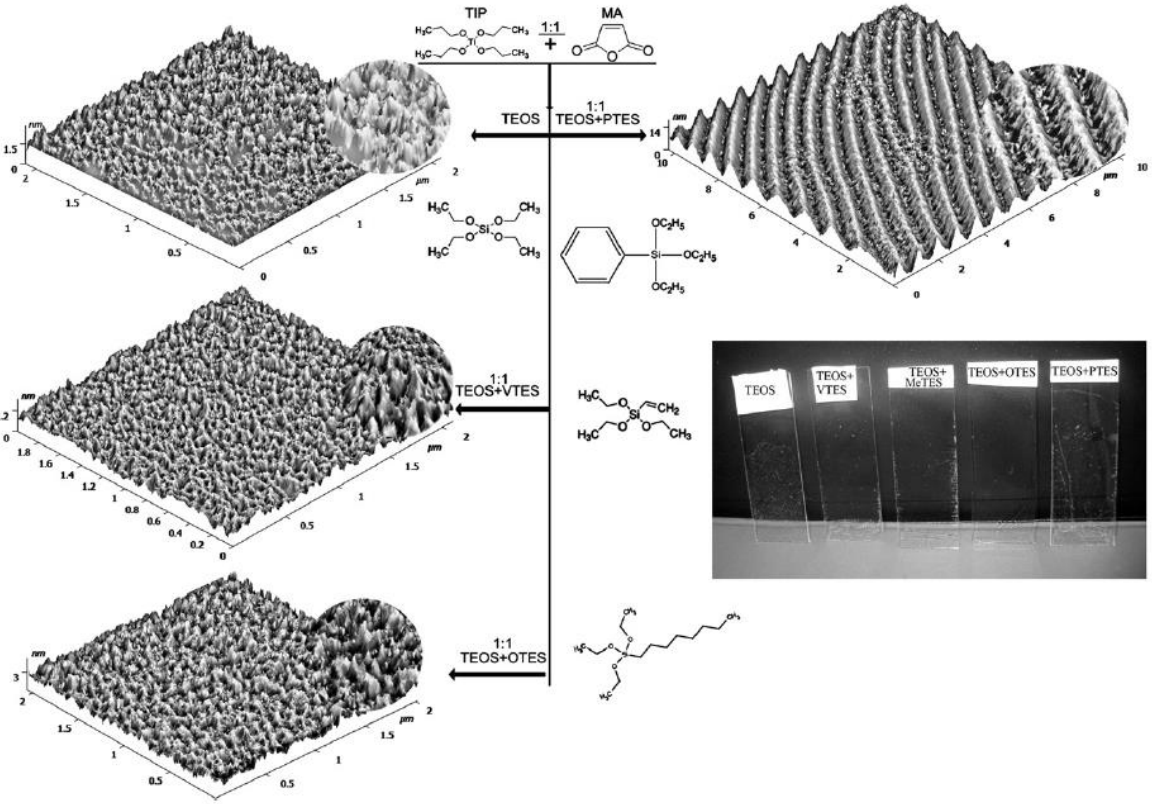
Figure 11. AFM images of the silica films prepared with different precursors and photo of the films deposited on glass slides, respectively. Reproduced with permission from [58].